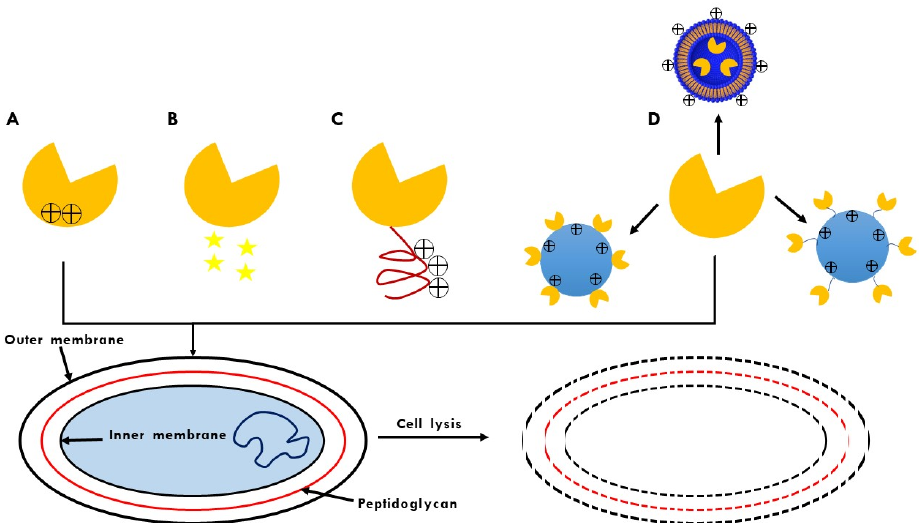
Figure 3. OM penetration strategies for endolysins: ( A ) Identification of lysins with intrinsic OM permeability; ( B ) Use of outer membrane permeabilizers (OMP); ( C ) Design of endolysins with OMP-disruptive properties; ( D ) Formulation of endolysins in carrier systems that penetrate OM. Table 2. Endolysins activity against bacteria of clinical and nutritional